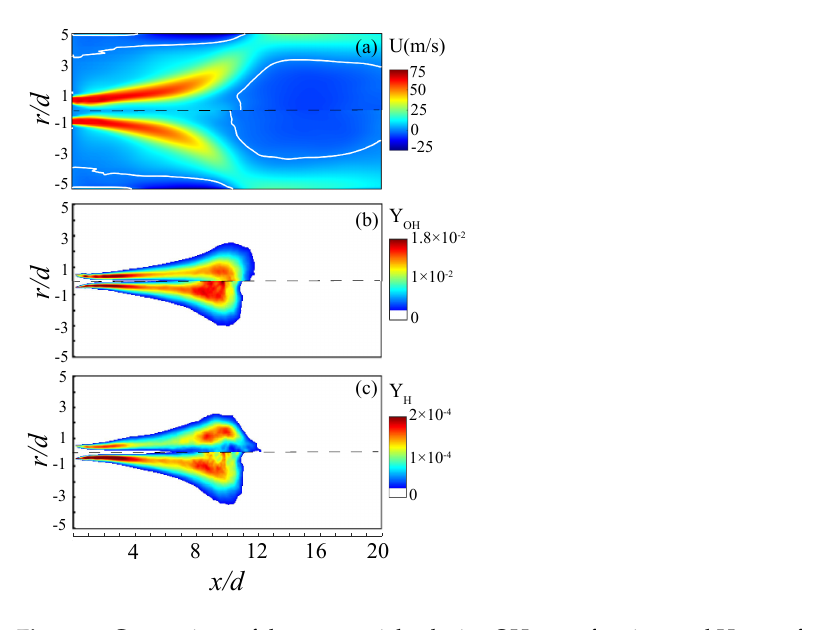
Figure 8. Comparison of the mean axial velocity, OH mass fraction, and H mass fraction distributions for the two LES cases. The upper panel of each subgraph is from Case 1, and the lower panel is from Case 2. ( a ) Mean axial velocity. ( b ) Mean OH mass fraction. ( c ) Mean H mass fraction. The white line shows the isoline of zero axial velocity.